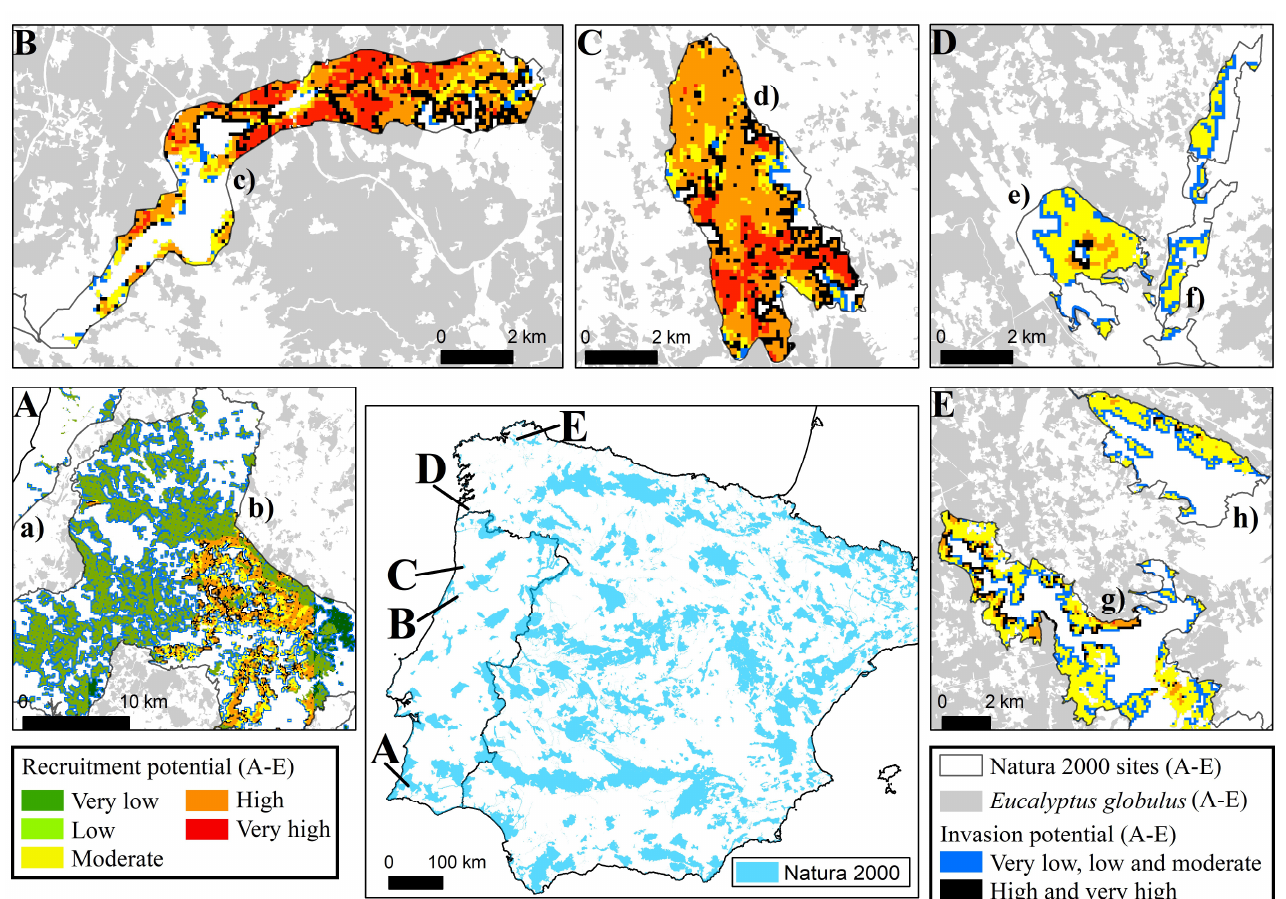
Figure 4. Terrestrial Natura 2000 in the Iberian Peninsula (central frame) and recruitment potential and invasion potential of Eucalyptus globulus inside some Natura 2000 sites (frames ( A – E )). Sites include: ( a ) Costa Sudoeste (PTCON0012 and PTZPE0015); ( b ) Monchique (PTCON0037); ( c ) Rio Vouga (PTCON0026); ( d ) Valongo (PTCON0024); ( e ) Monte Aloia (ES1140005); ( f ) G á ndaras de Budiño (ES1140011); ( g ) Fragas do Eume (ES1110003); ( h ) Xubia-Castro (ES1110013). Areas under invasion potential of any class covered 877.7 km 2 across 176 sites (Table